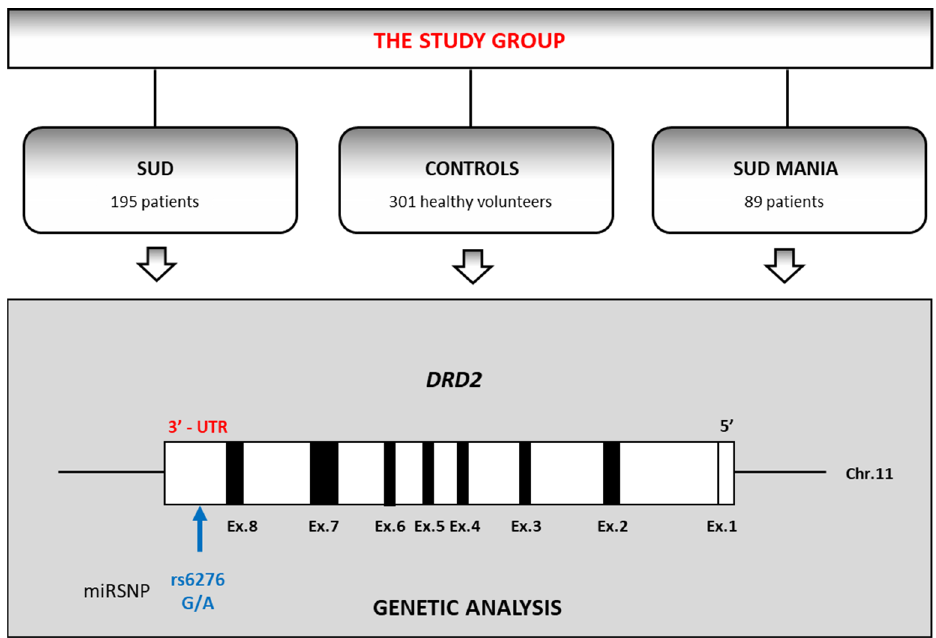
Figure 1. The flowchart of the study design (SUD—patients diagnosed with substance use disorder; SUD MANIA—patients with diagnosis substance use disorder comorbid with maniac episodes). DRD2 gene is drawn to scale with black boxes representing exons and white boxes representing untranslated regions.